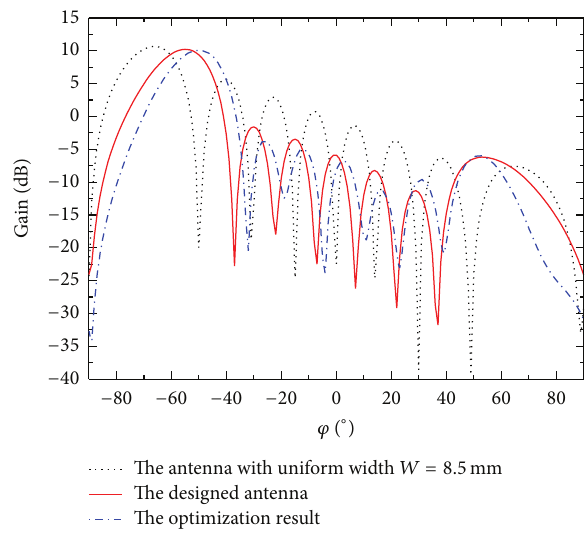
Figure 10: Radiation patterns of the designed antenna before and after